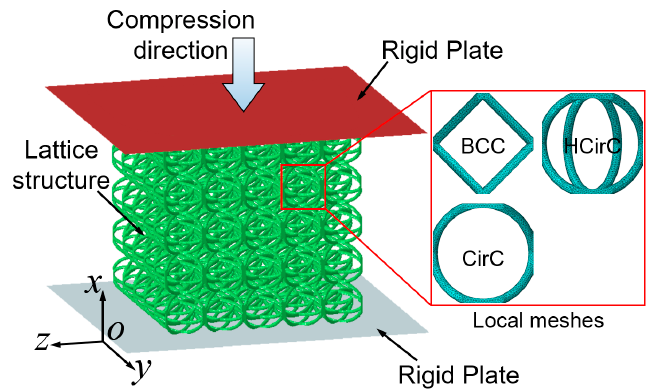
Figure 6. The FE model, geometry coordinates, boundary constraints, and local meshes.